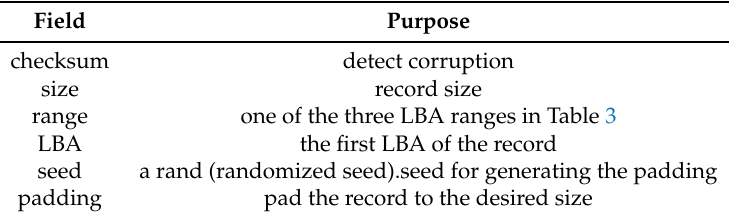
Table 4. Format of a